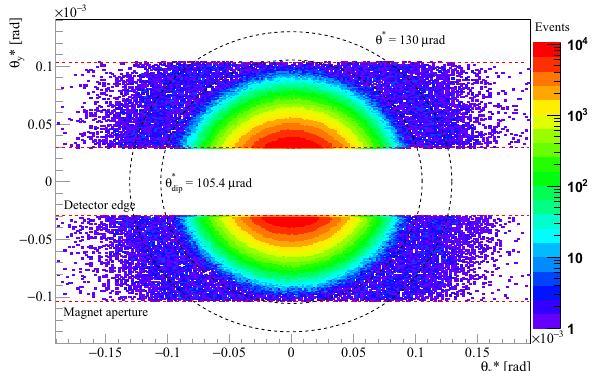
Fig. 4 The azimuthal distribution of the scattering angle θ ∗ demon- strates the azimuthal symmetry of elastic scattering on a data sample from Diagonal 1 and 2. The red dashed lines show the analysis accep- tance cuts, which define the acceptance boundaries near the detector edge and magnet aperture. The inner black dashed circle illustrates the approximate scattering angle position θ ∗ of the diffractive minimum dip in the data